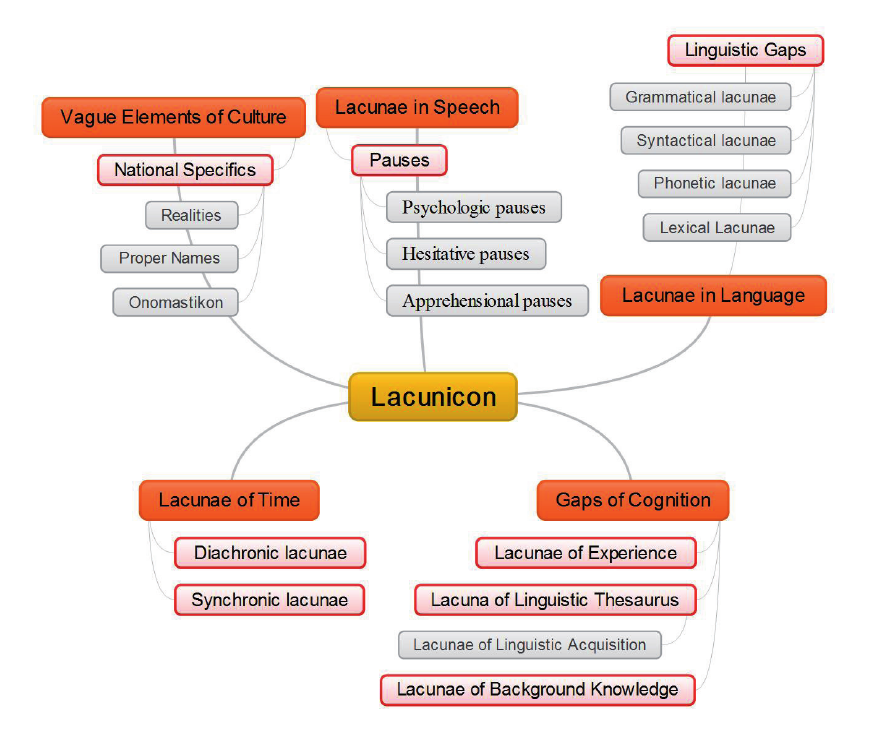
Fig. 2. The Lacunicon (paradigmatic, syntagmatic, temporal and cognitive